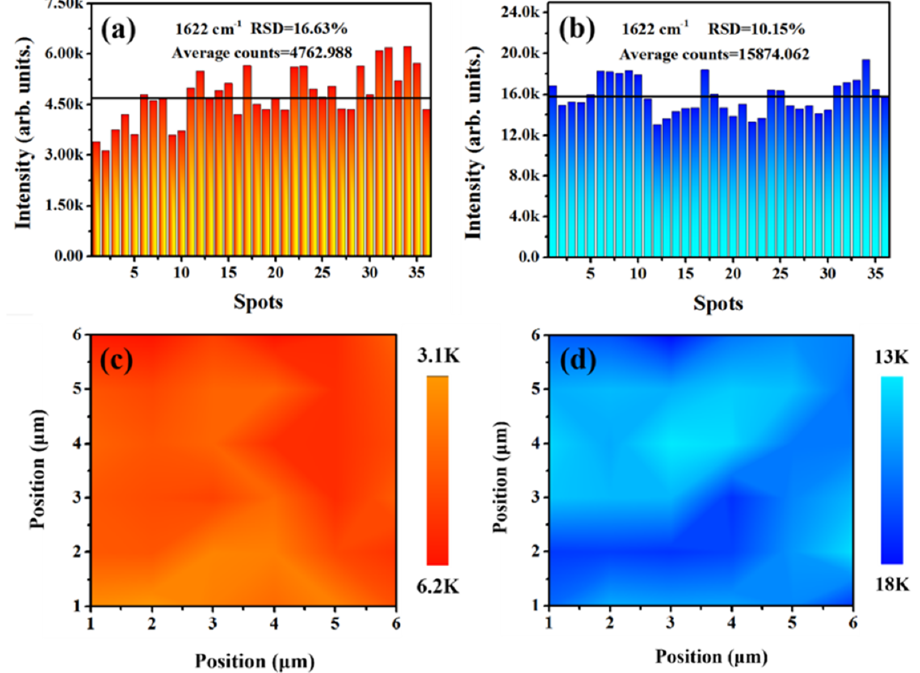
Figure 6. ( a , b ) SERS intensity of 10 − 5 M MB at a characteristic peak of 1622 cm − 1 recorded from 36 randomly selected points from the AgCu@MW ‐ 20 and Ag@Cu@MW ‐ 3 substrates. ( c , d ) SERS map ‐ ping image (6 × 6 μ m 2 , 1 ‐μ m step size) corresponding to the SERS intensity of the above 36 points.